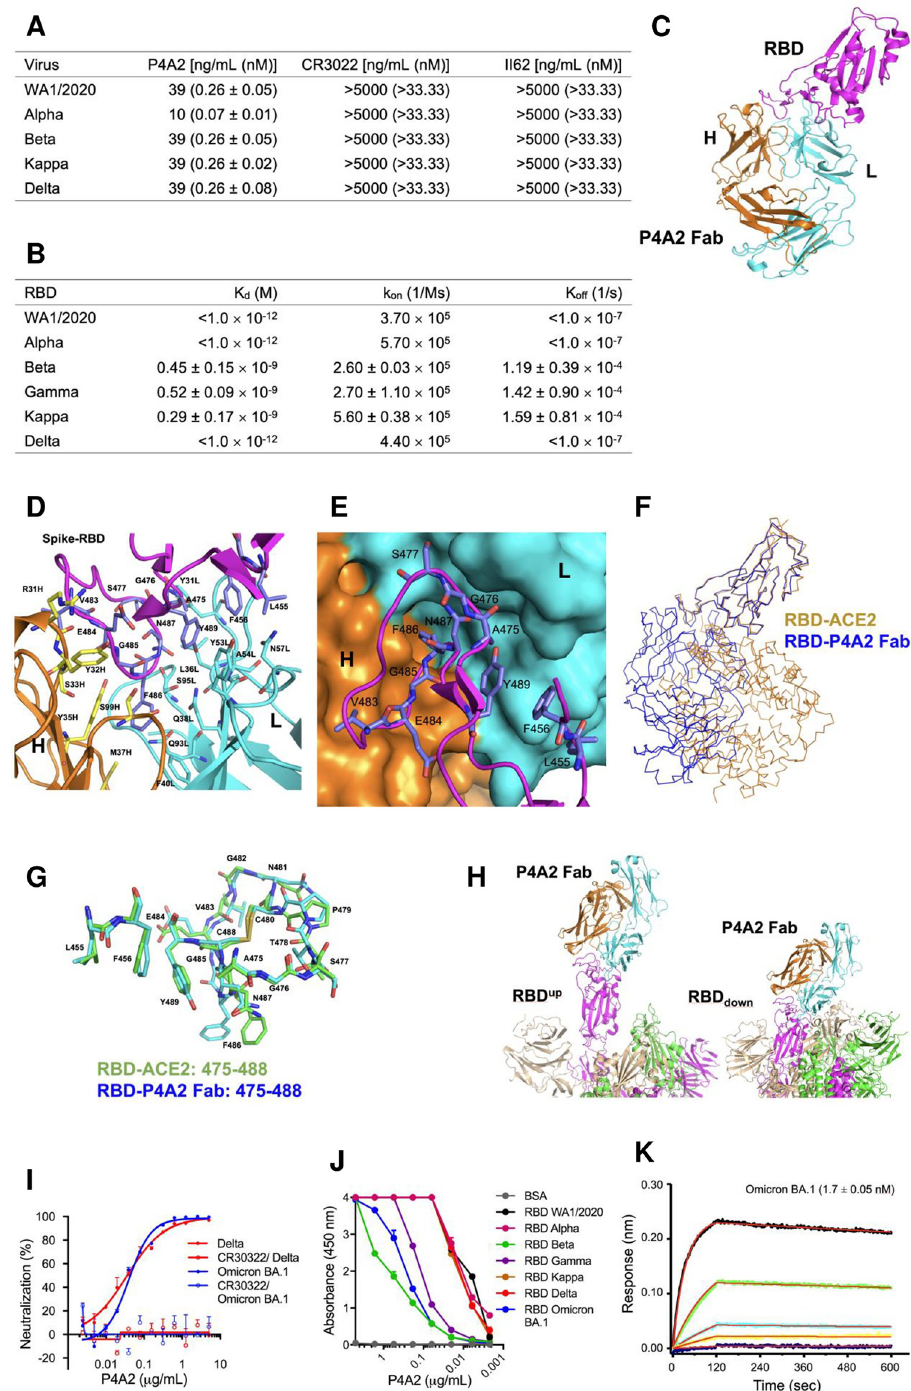
Fig 1. Biochemical and structural analysis reveals that P4A2 mAb can neutralize all circulating variants of concern. (A) Neutralization of authentic SARS-CoV-2 VOCs by P4A2 was determined using virus-induced cytopathic effect (CPE) based assay, neutralization values are shown in ng/mL and nmol. (B) Kinetics of P4A2 binding to RBDs from VOCs was assessed by Bio-Layer Interferometry (BLI) Octet. (C) Structure of P4A2 Fab in complex with RBD of Alpha variant. The heavy (H) and light (L) chain of P4A2 Fab are coloured in orange and cyan, respectively and the RBD is coloured magenta. (D) The interacting residues from P4A2 paratope and the RBD epitope are displayed in stick representation and coloured according to element. The carbon atoms of H chain, L chain and RBD are coloured